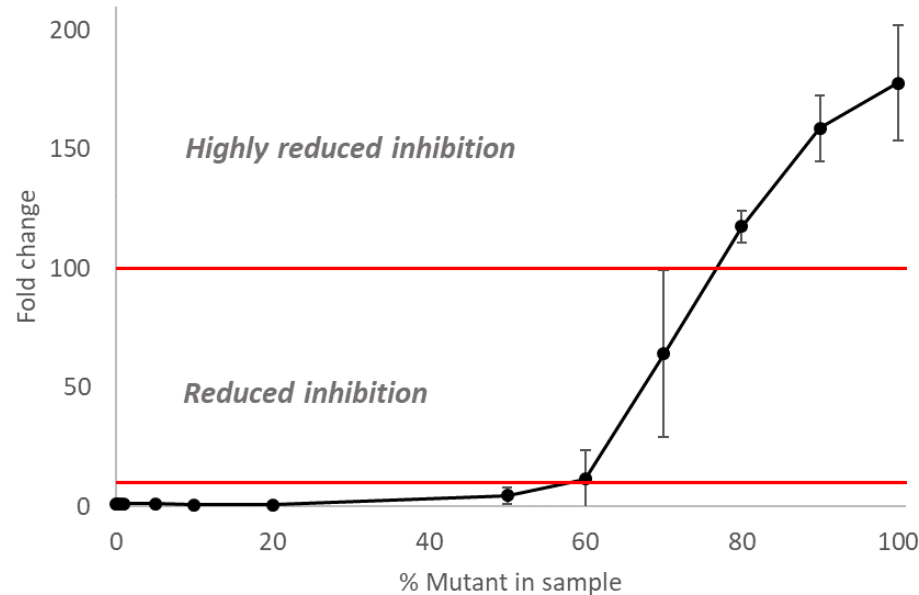
Figure 4. Inhibitory activity of oseltamivir on mixed populations of NAI-susceptible and